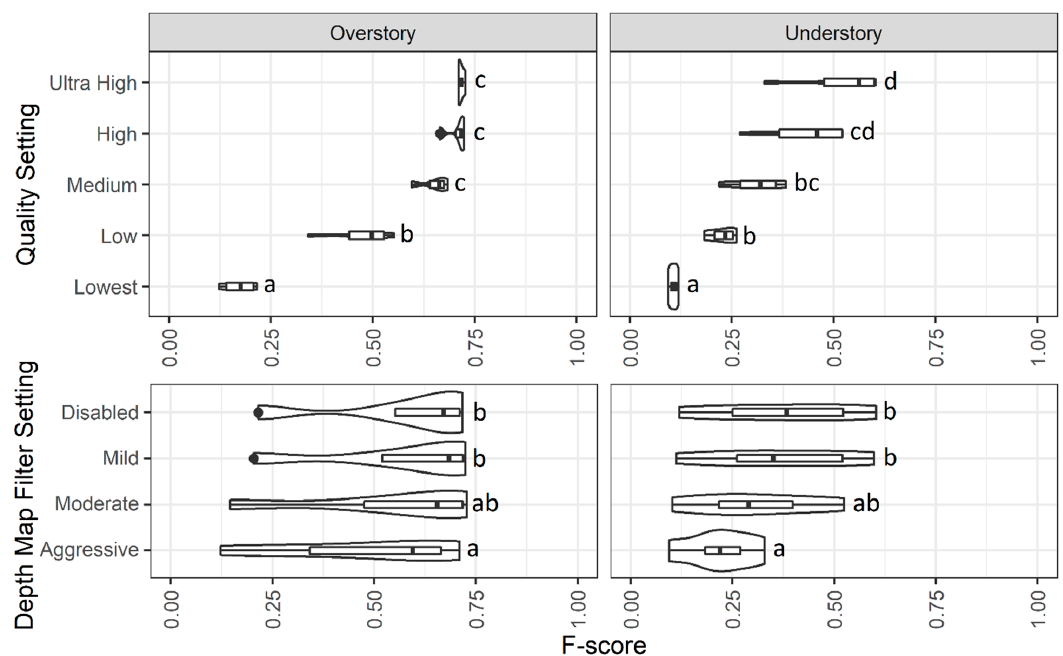
Figure 4. Influence of Metashape build dense cloud Quality and depth map filter settings on individual tree detection (ITD) F-score for overstory and understory trees presented as violin plots to portray the distribution of data points. Letters represent significant difference ( α = 0.05) determined by two-way ANOVA with Tukey’s HSD test.